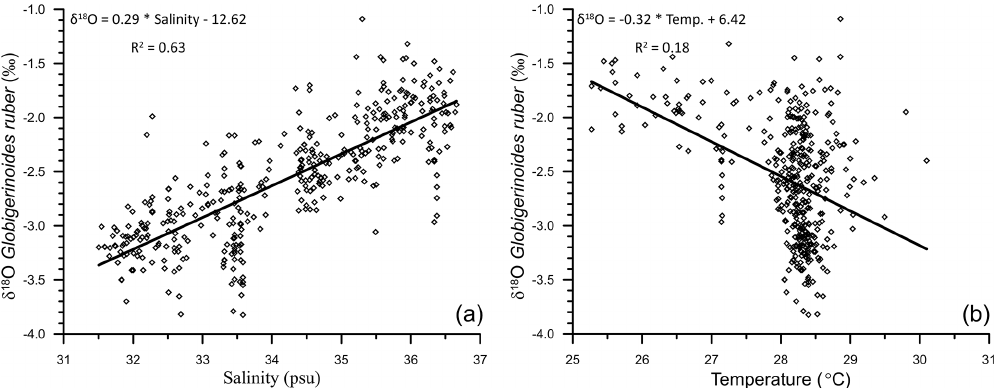
Figure 6. The relationship between the stable oxygen isotopic ratio of the mixed-layer-dwelling Globigerinoides ruber and annual average mixed layer salinity (a) and temperature (b) in the northern Indian Ocean.